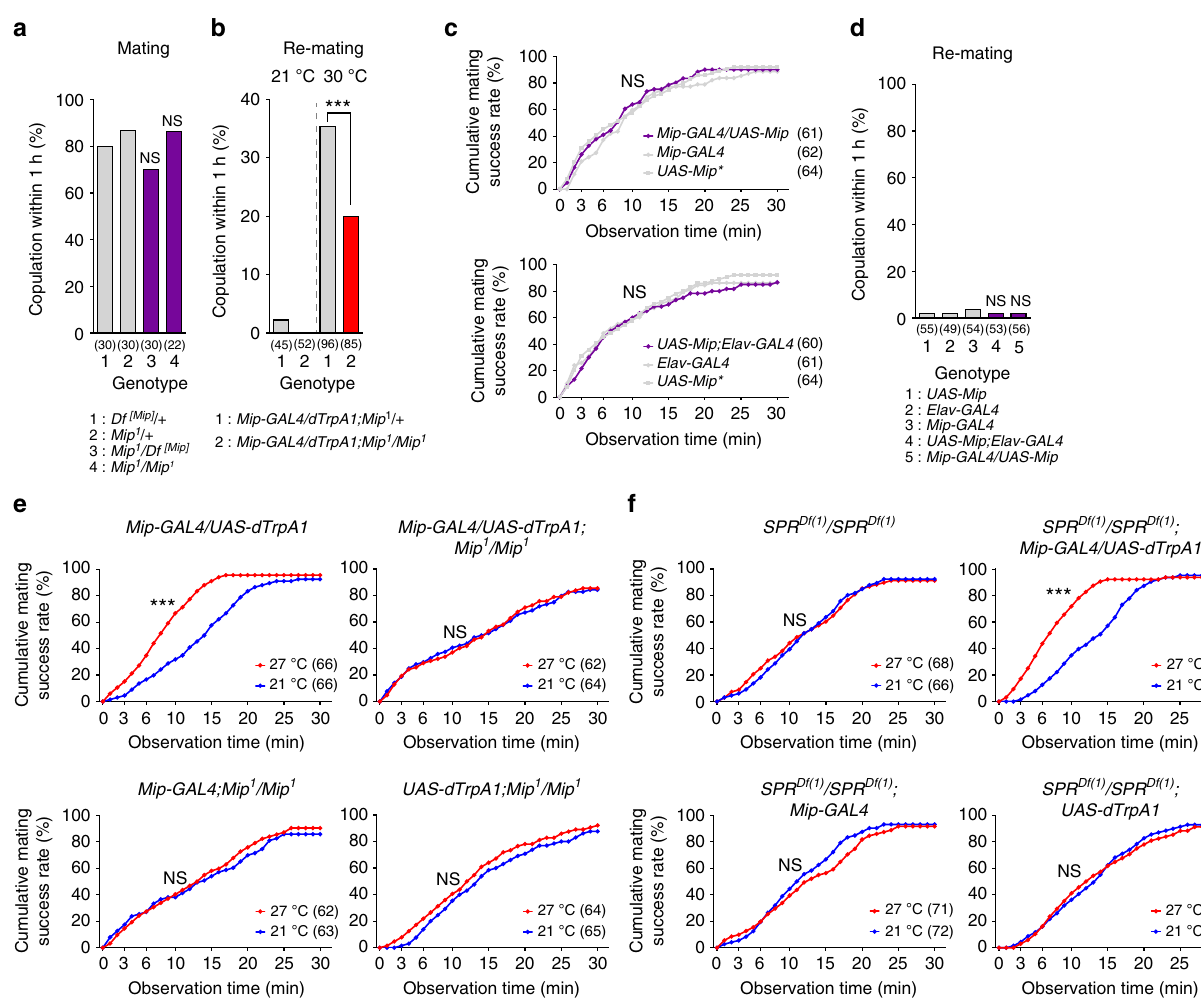
Fig. 3 A function of Mip peptides in female mating receptivity. a Mating frequencies of virgin females of the indicated genotypes, scored as the percentage of females that copulate within 1h. b , d Re-mating frequencies of mated females. NS indicates non-signi fi cance ( P > 0.05); *** P < 0.001 for comparisons against controls; Chi-square test a , b , d . c , e , f Cumulative mating frequencies of virgin females. The numbers in parentheses indicate n . NS indicates non-signi fi cance ( P > 0.05); *** P < 0.001 for comparisons against genetic controls (grey bars or dots in a – d ) or a temperature control (blue in e , f ); Chi-square